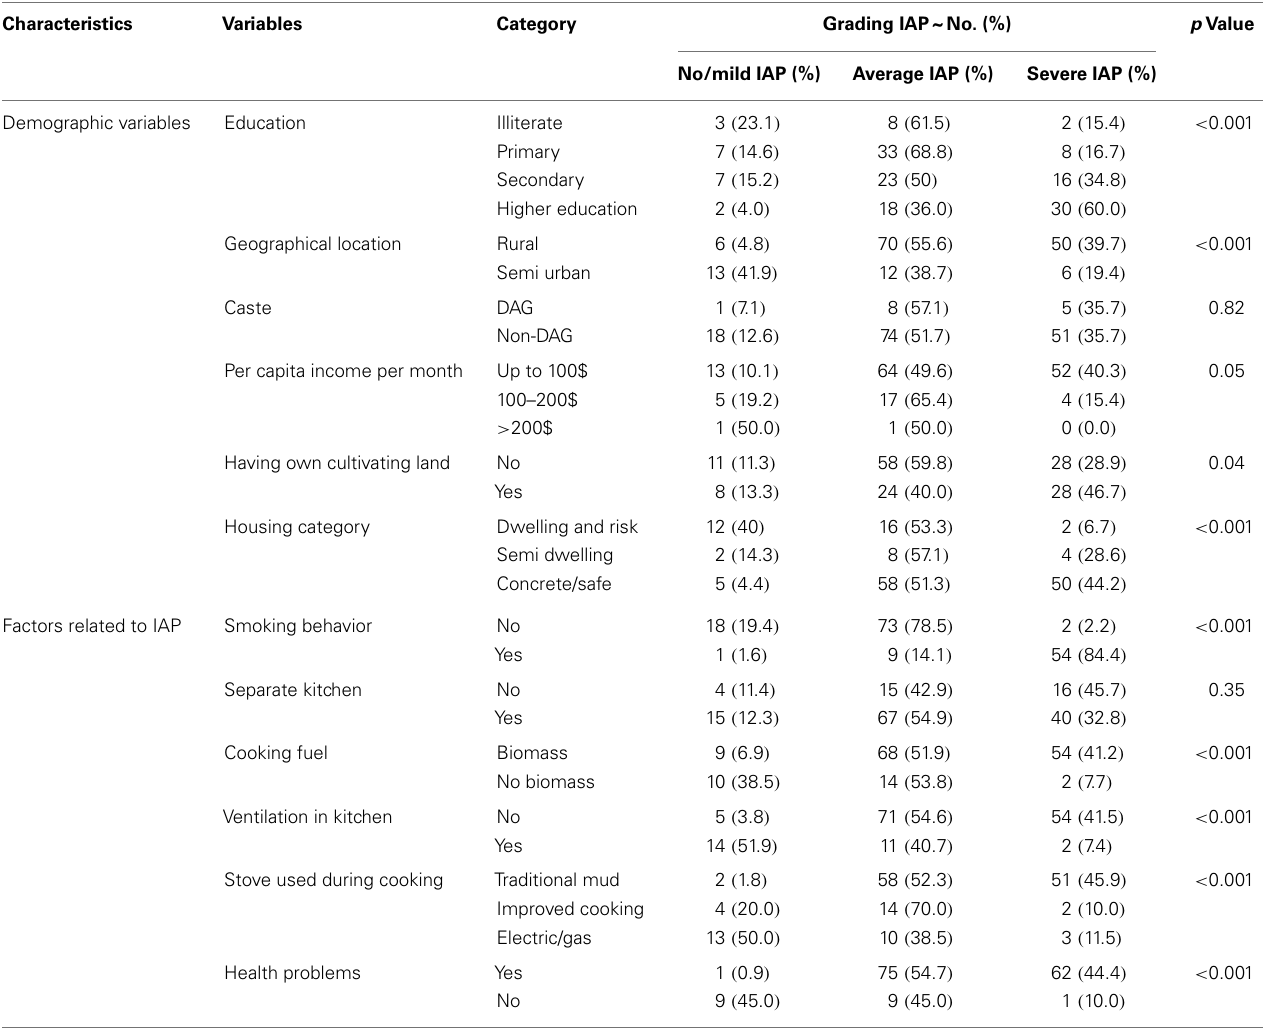
Table 4 | Descriptive findings from study (N = 157)